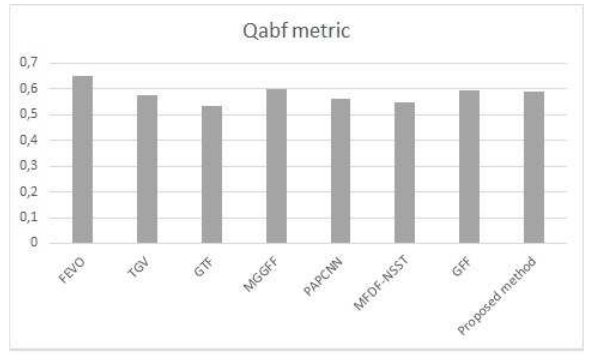
Figure 10. Diagram of the quality assessment by Q AB/F metric Also, we compared image processing results with other modern image fusion methods by computation time (Table 1). Experi- ments are performed in MATLAB R2015a, Intel Core i7-5500U CPU 2.40